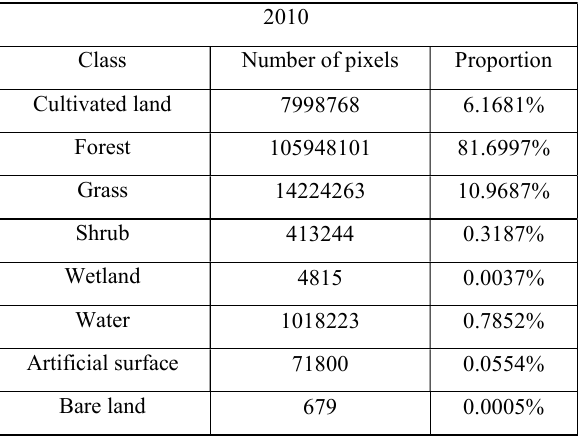
Table 6 Statistics of surface coverage types of products in